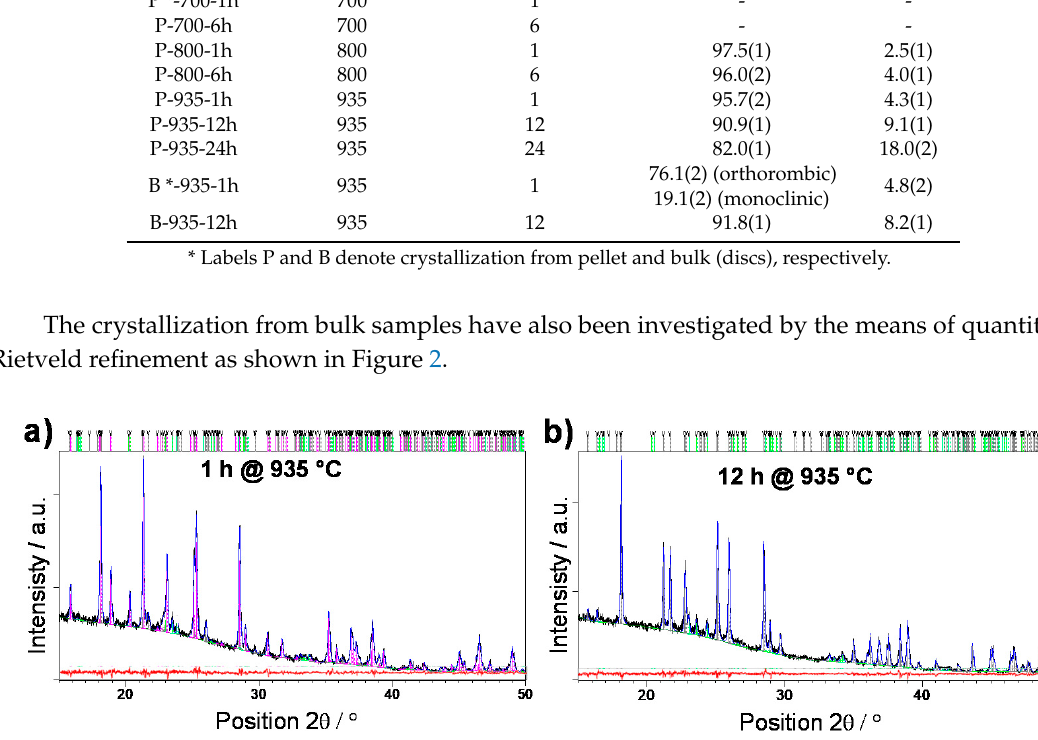
Figure 2. Rietveld refinements of the bulk glass samples crystallized for ( a ) 1 h and ( b ) 12 h at 935 °C. Experimental data are given by black line, the calculated pattern is shown in blue, while the red line represents the difference curve. Grey vertical marks show the positions of diffraction lines belonging to monoclinic W 2 O 3 (PO 4 ) 2 phase, magenta bars represent reflection of orthorhombic W 2 O 3 (PO 4 ) 2 phase, while the positions of WO 3 lines are given as green vertical marks.